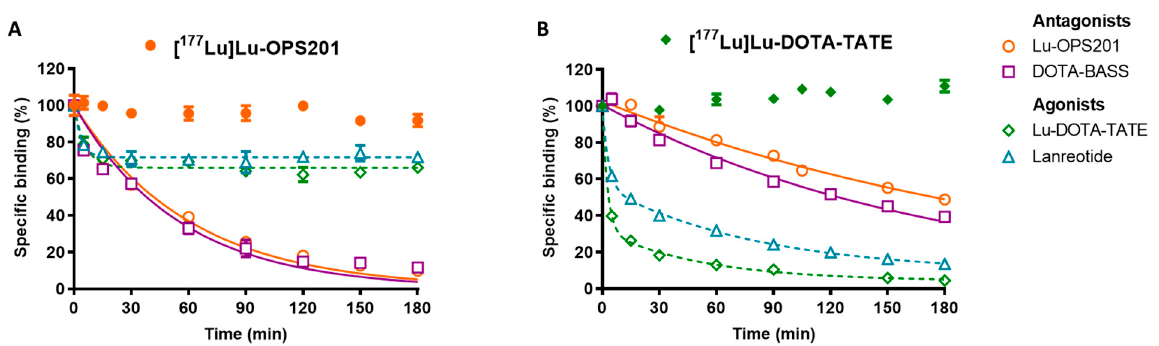
Figure 2. Dissociation of [ 177 Lu]Lu-OPS201 ( A ) and [ 177 Lu]Lu-DOTA-TATE ( B ) from HEK-SST 2 cell membranes in the presence of an excess of the unlabelled competitors: antagonists Lu-OPS201 and DOTA-BASS (data points connected with solid lines) and agonists Lu-DOTA-TATE and lanreotide (data points connected with dashed lines). Data are representative of two independent experiments, each performed in triplicate. To control the stability of the radioligand–receptor complexes, membranes were incubated with [ 177 Lu]Lu-OPS201 ( • ) and [ 177 Lu]Lu-DOTA-TATE ( (cid:7) ), without the addition of any competitor (indicated by the non-connected solid symbols in both graphs) during the same extended timespan.